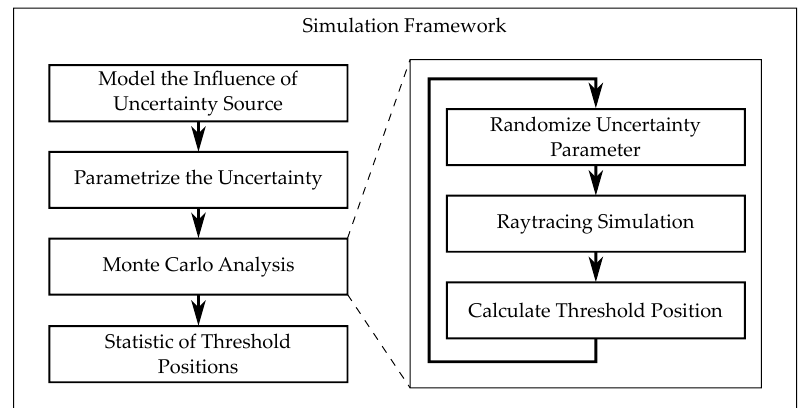
Figure 8. Simulation framework. Steps done for each source of